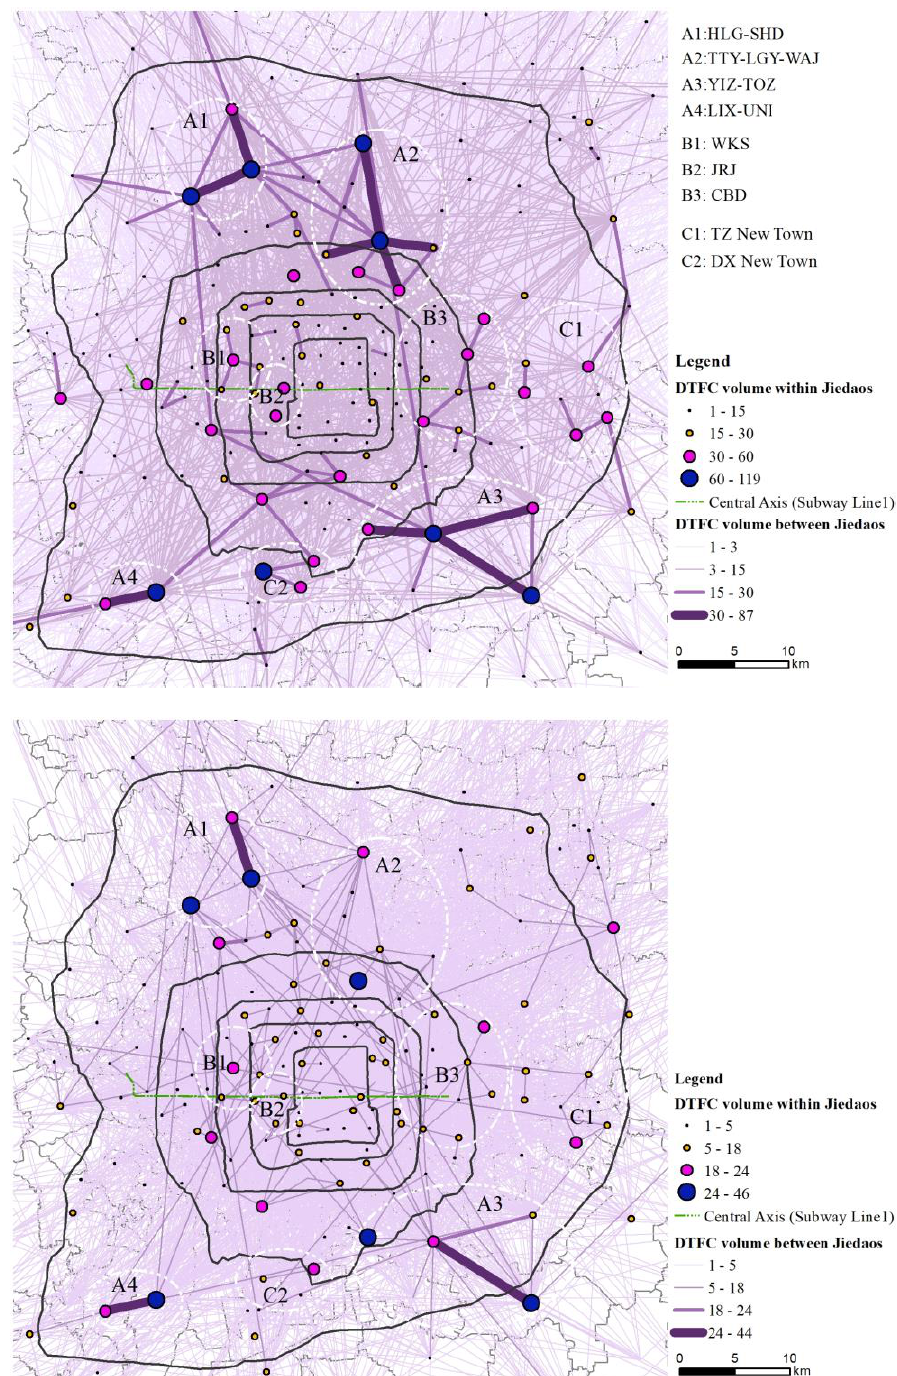
Figure 8. DTFC flow patterns on weekdays and weekends. Three categories, namely A, B, C, are identified by high volumes or densities, representing the main interaction mode between urban units — Jiedaos. Each category has a spatial correlation with housing or employment places, based on table 2. Table (1) Category A: A1 – A4 are the most high-density regions and are in suburban ar- eas. They consist of strong interactions between large residential communities and high employment opportunity areas. These regions are located between the fifth and sixth ring